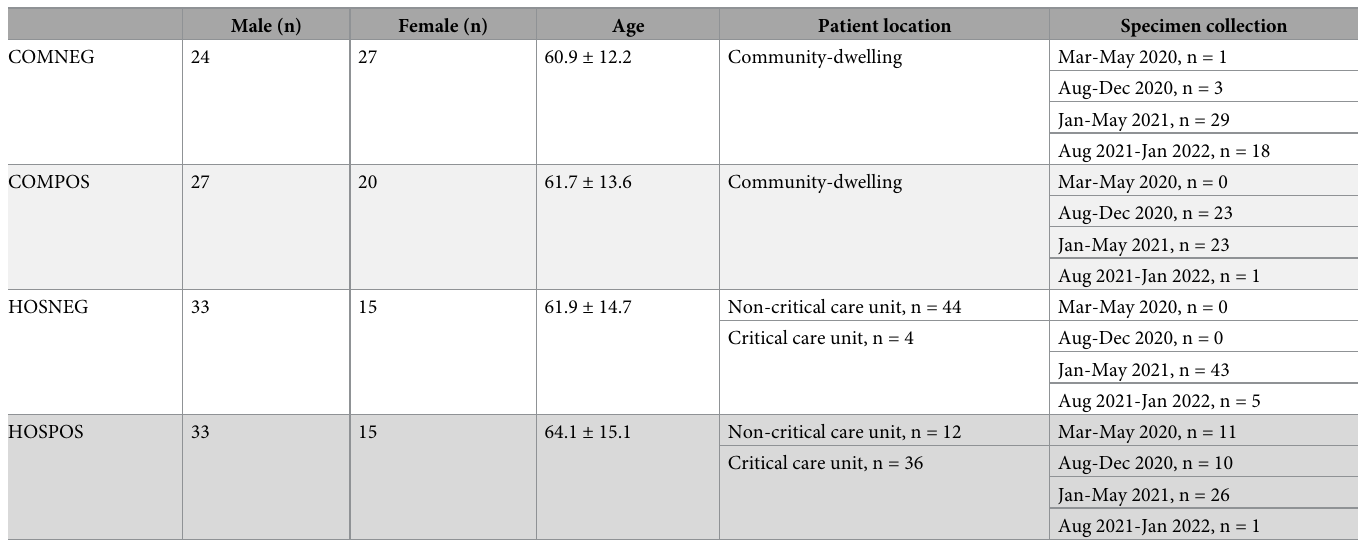
Table 1. Summary of study population